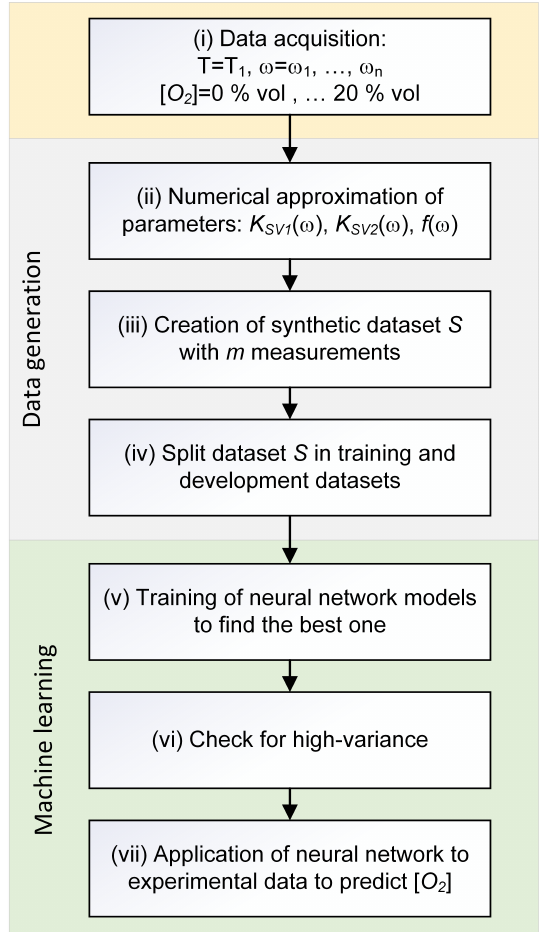
Figure 2. Schematic overview of the steps of the machine learning